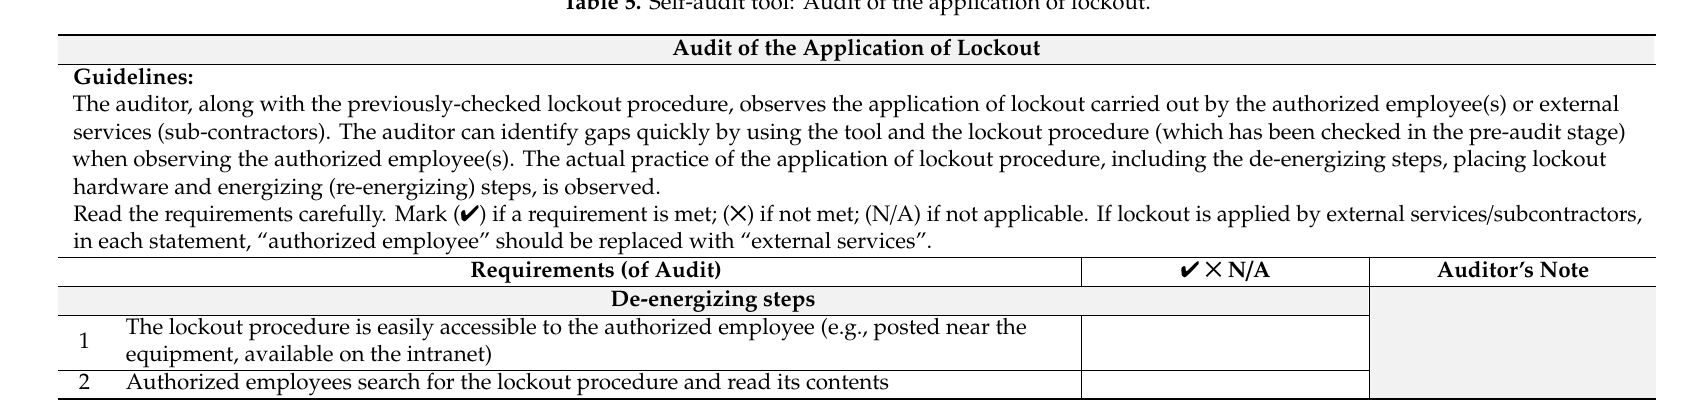
Table 5. Self-audit tool: Audit of the application of